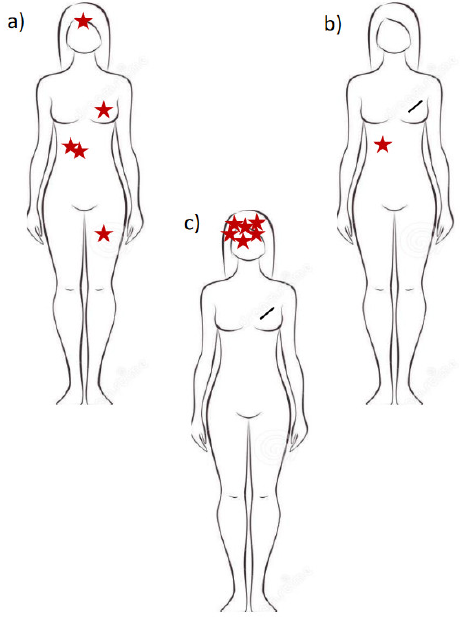
Figure 1. Oligometastatic disease. Model of different presentations of oligometastatic breast cancer: ( a ) Patient with the de novo oligometastatic disease: primary breast cancer, and two metastases in the liver, one in the bones and one in the brain; ( b ) Patient with an isolated liver metastasis; ( c ) Patients with six brain lesions: a radical approach could potentially be performed on all these metastases.